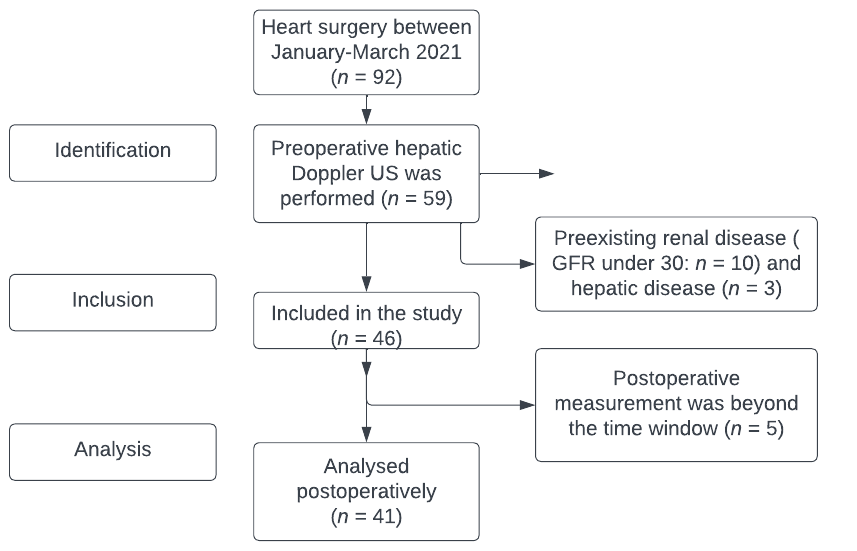
Figure 1. Flowchart by STROBE statement (identification–inclusion–analysis). Detailed information in Supplementary Materials File S1.